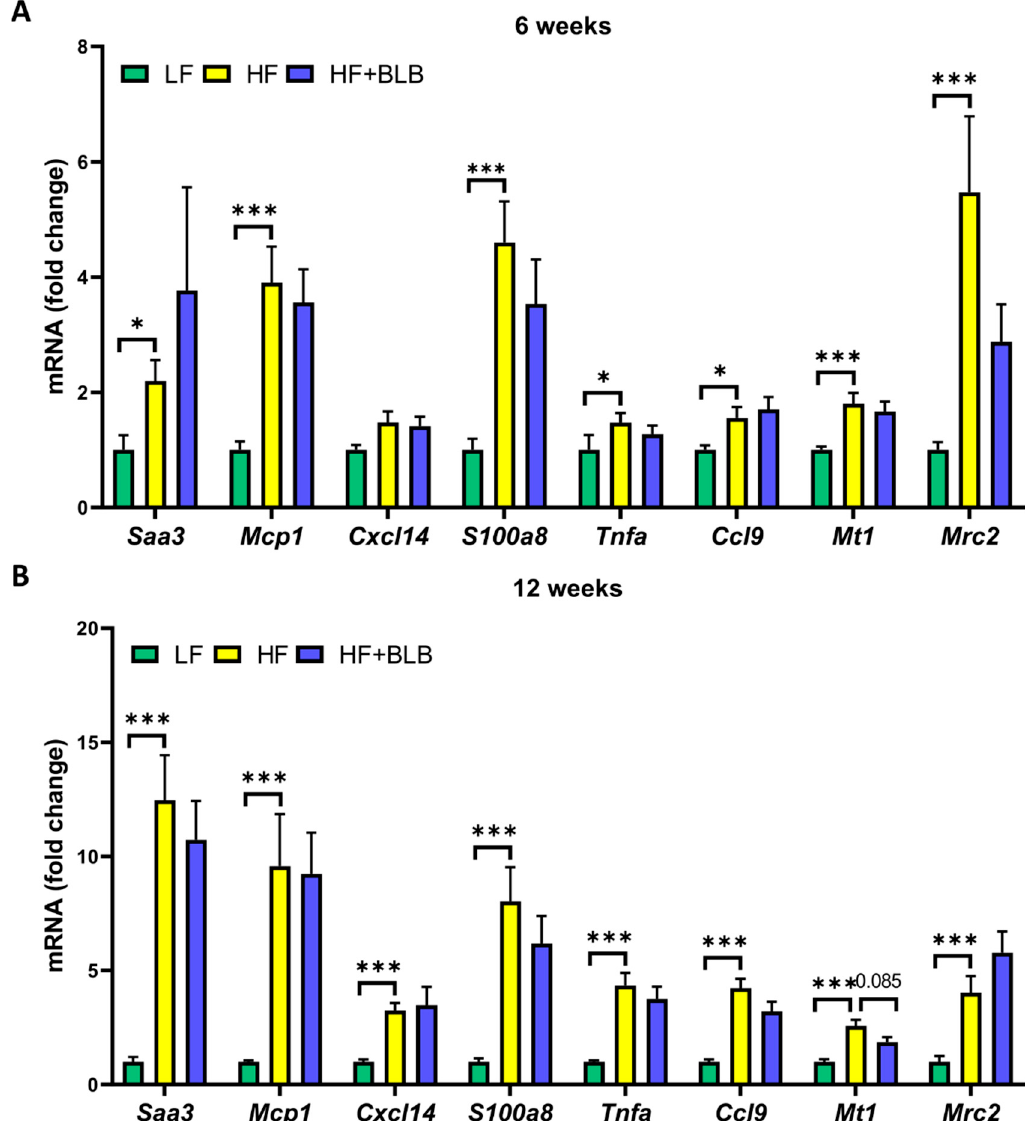
Figure 7. Gene expression in the epididymal fat tissue. The mice received a low-fat diet (LF, 10% energy from fat), a high-fat diet (HF, 46% of energy from fat) or a bilberry-supplemented high-fat diet (HF+BLB, 20% air-dried bilberry powder) for six ( A ) or twelve ( B ) weeks. The gene expression was measured with RT–PCR and normalized against the housekeeping gene glyceraldehyde 3-phosphate dehydrogenase ( Gapdh ). The expression levels were then compared to the mean expression level in the LF group, which was set as 1. The results are expressed as a fold change and analyzed with a one-way ANOVA and a Bonferroni multiple comparisons test. The statistically significant differences from the HF group are marked with * p < 0.05 and *** p < 0.001. Values represent mean + SEM, n = 12 mice in each group. Saa3 = serum amyloid A3, Mcp1 = monocyte chemoattractant protein 1, Cxcl14 = chemokine (C-X-C motif) ligand 14, S100a8 = S100 calcium-binding protein A8, Tnfa = tumor necrosis factor α , Ccl9 = chemokine (C-C motif) ligand 9, Mt1 = metallothionein 1, Mrc2 = mannose-receptor C type 2.